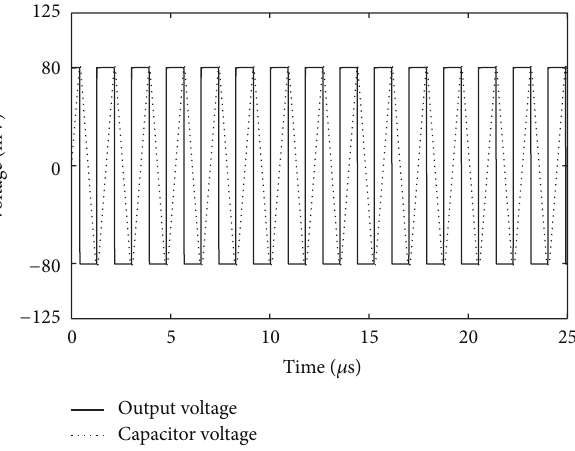
Figure 13: Output and capacitor’s voltage waveform of pulse generator.